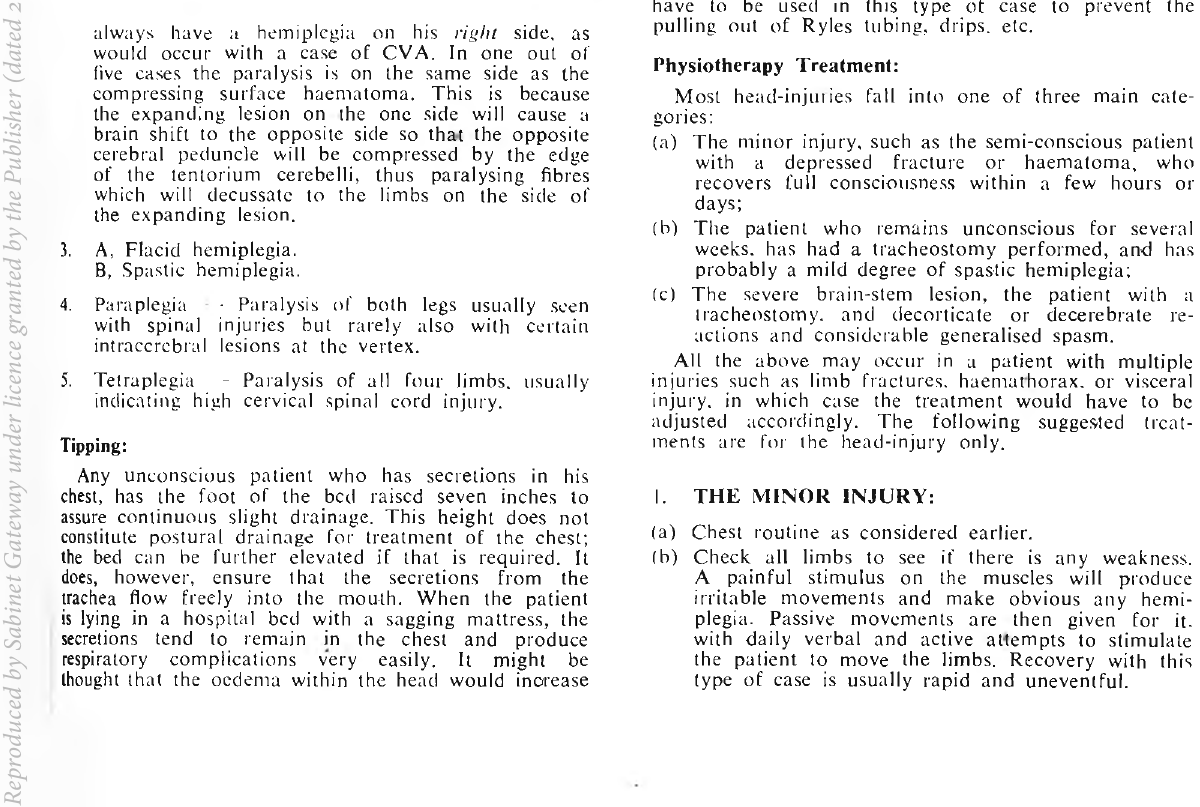
Fig. 2. The typical internally rotated arm of a decere brate patient. Any external stimulus will produce ex> trenie extensor spasm in the